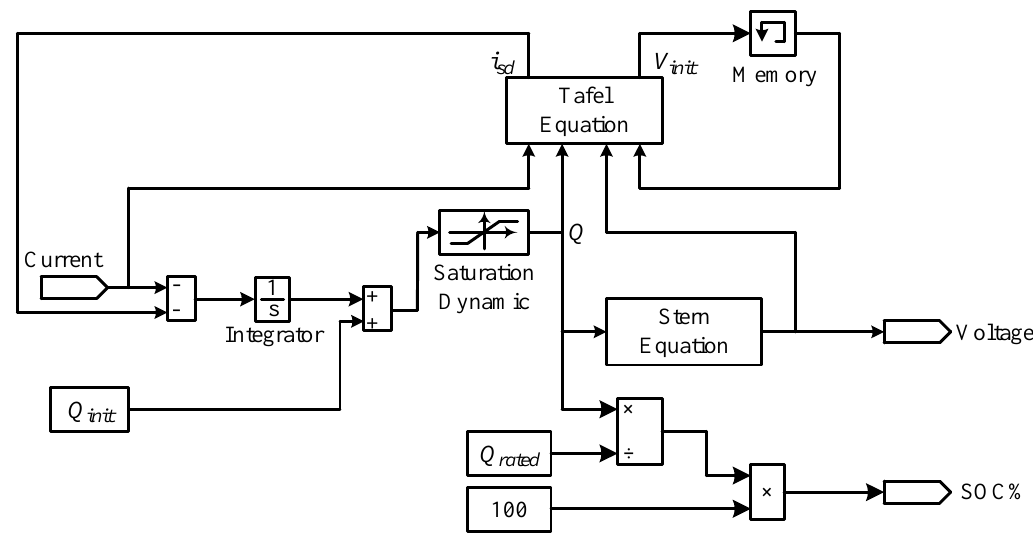
Figure 3. Block diagram of the detailed dynamic